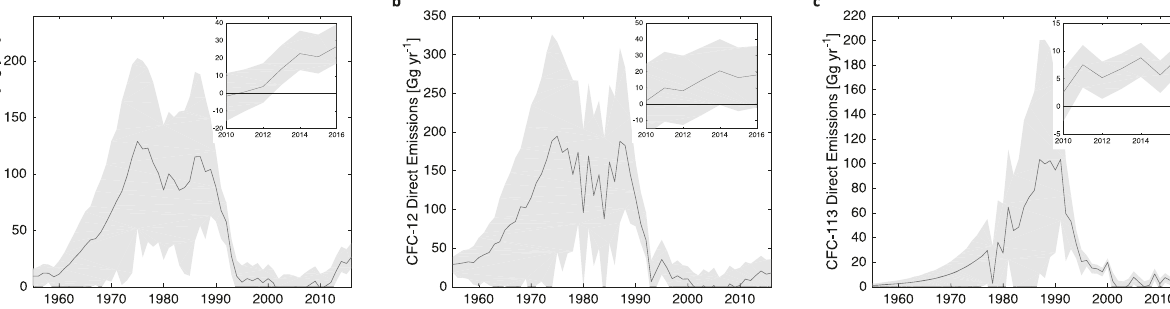
Fig. 6 Direct total emissions. Posterior top-down total emissions estimates minus posterior bank emissions for ( a ) CFC-11 ( b ) CFC-12, and ( c ) CFC-113. Shaded region indicates the 95% con fi dence interval.